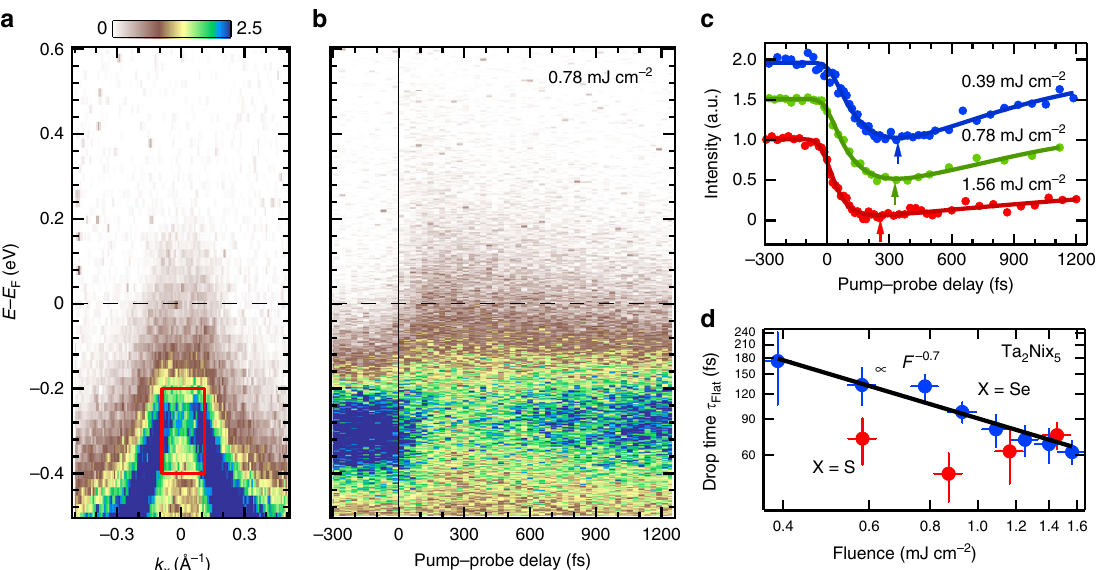
Fig. 2 Collapse of the fl at band in Ta 2 NiSe 5 . a Energy – momentum map of Ta 2 Ni(Se 0.97 S 0.03 ) 5 measured by using an XUV pulse (27.9 eV) before the arrival of the pump pulse (1.55 eV) at 100 K. b TARPES spectrum at the Γ point, obtained with a pump fl uence of 0.78 mJ cm − 2 . c Temporal evolution of the integrated TARPES intensity in the red square shown in a for different pump fl uences. The arrows indicate the minimum values of the spectral weight. d Extracted drop time of the fl at band τ Flat as a function of the pump fl uence. Blue and red symbols corresponds to Ta 2 Ni(Se 0.97 S 0.03 ) 5 and Ta 2 NiS 5 , respectively. The error bars roughly correspond to the standard